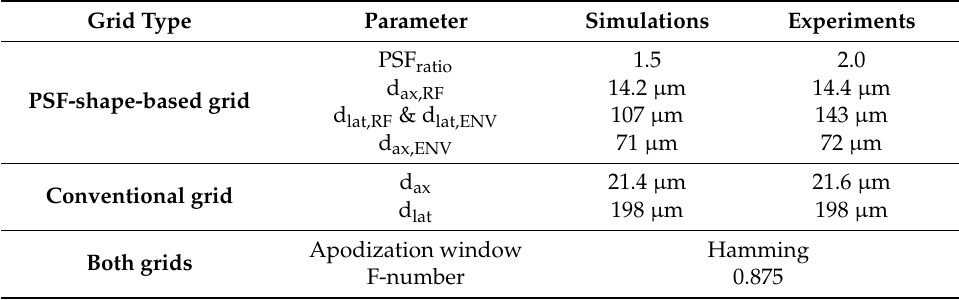
Figure 3. ( a ) Simulated PSFs at spatial positions relevant for carotid artery imaging. ( b ) Intensity curves in axial and lateral direction. The red lines indicate the − 6 dB level. Table 3. Beamforming parameters. PSF: point-spread-function.